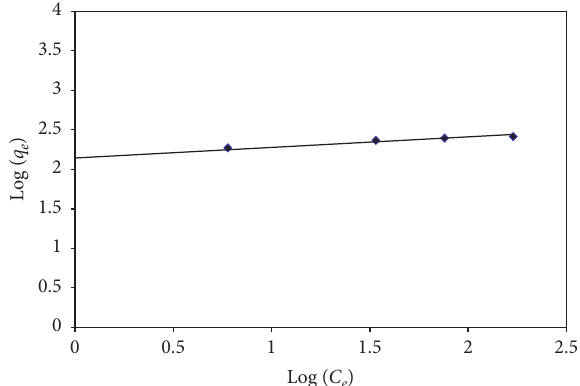
Figure 9: CV Freundlich adsorption isotherm using Khulays natural